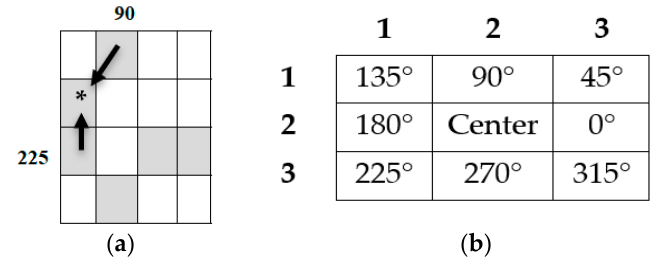
Figure 7. ( a ) Two neighboring edge pixels, ( b ) EDMs principal.